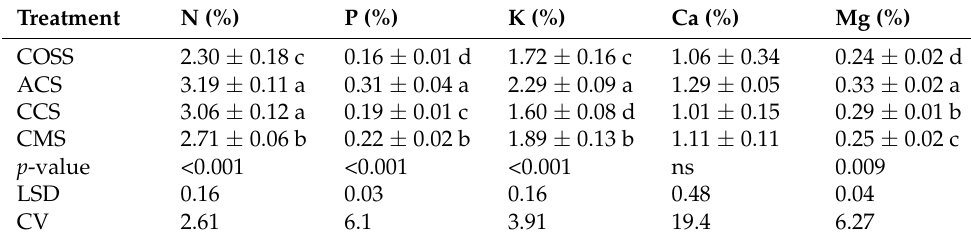
Table 3. Mean ± SD of effects of SMCPs on coffee plant tissue